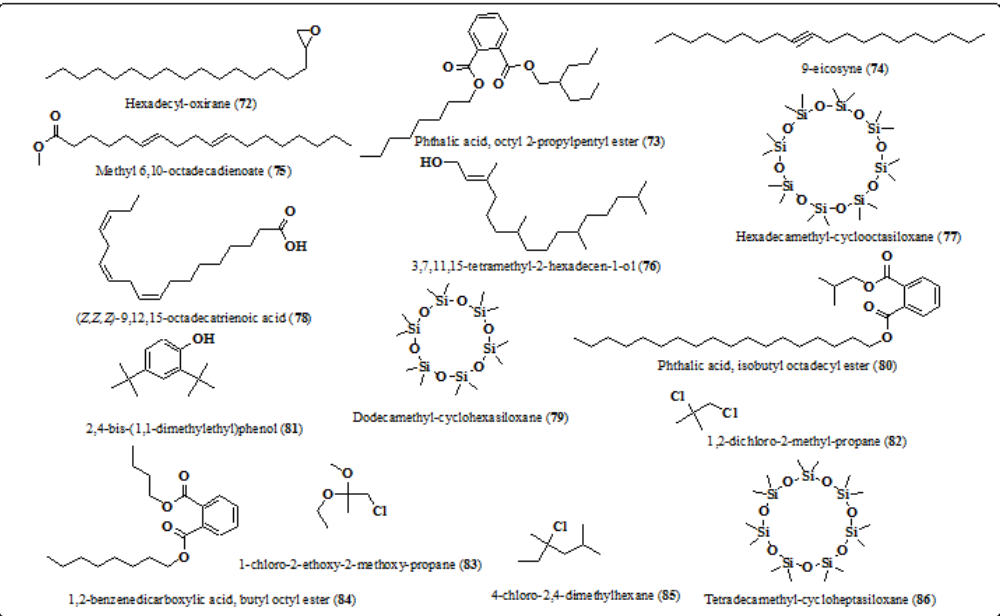
Figure 10. Structures of compounds from E. laevis ( 72 – 86 ).